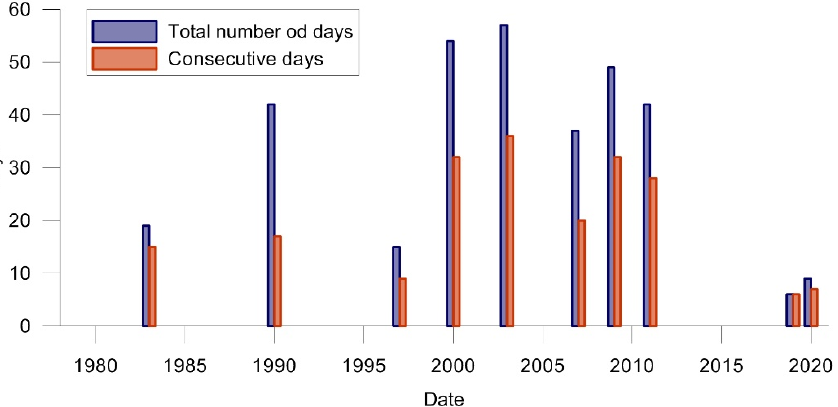
Figure 12. Total number of days and consecutive days of the Korana River running dry at the Luketi ć i hydrological station in the 1978–2020 period (with an interruption during 1991–1995).